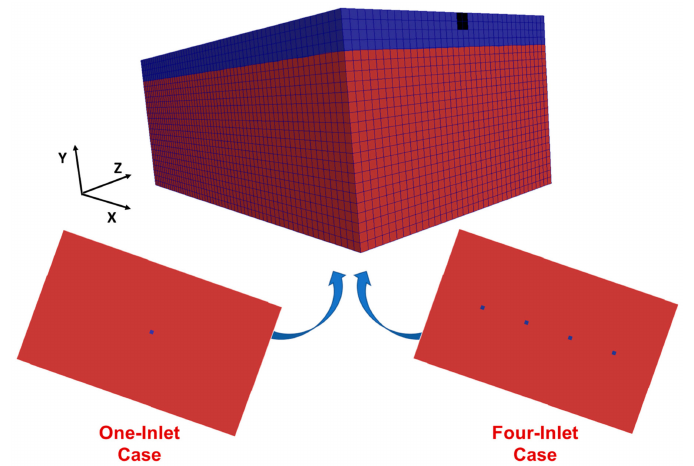
Figure 2. Schematic representation of the fuel tank mesh. The region initially containing fuel is coloured in red while the ullage is coloured in blue. The black rectangle on the upper right side of the surface is the pressure valve of the system. The two rectangles below show the bottom plane for the one-inlet ( left ) and four-inlet ( right )